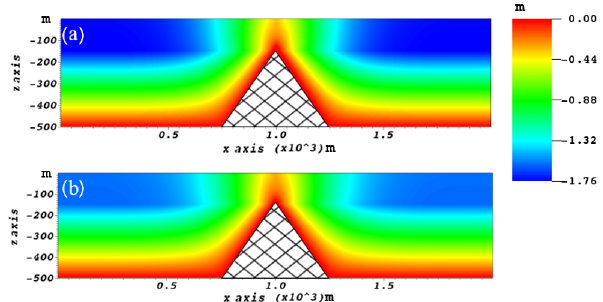
Figure 2. Simulated vertical displacements of the aquifer at the (a) 10th and (b) 20th time step.